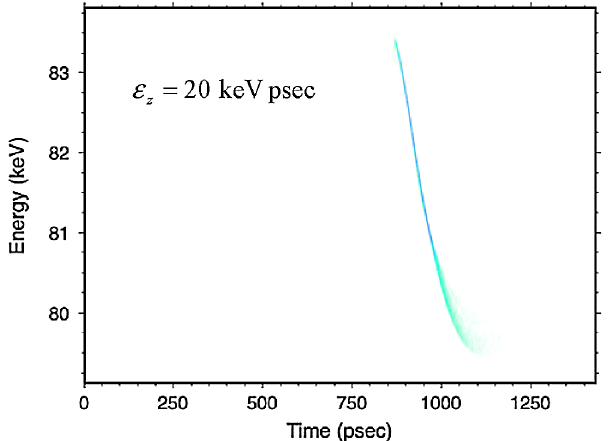
FIG. 13. Longitudinal phase space (energy vs time) for the gun geometry of Fig. 9. The normalized longitudinal emittance is " r q 2 =mc 2 . Since W =W < 1 and the electron bunch e ¼ b rf duration at the grid plane (cid:2) b (cid:1) 100 psec is greater than (cid:2) F , the rf energy in the cathode-grid region is not significantly depleted by the electron bunch. Simulations using